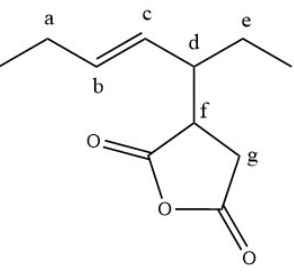
Figure 3. Base structure of the ASA moiety of the oleate’s main product.